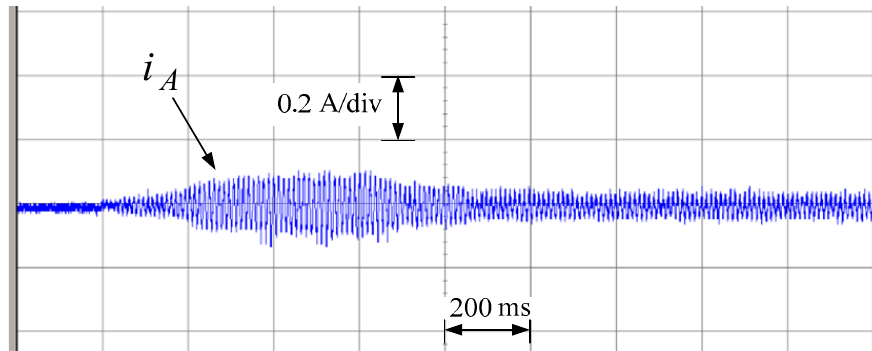
Figure 21. The current response without load.